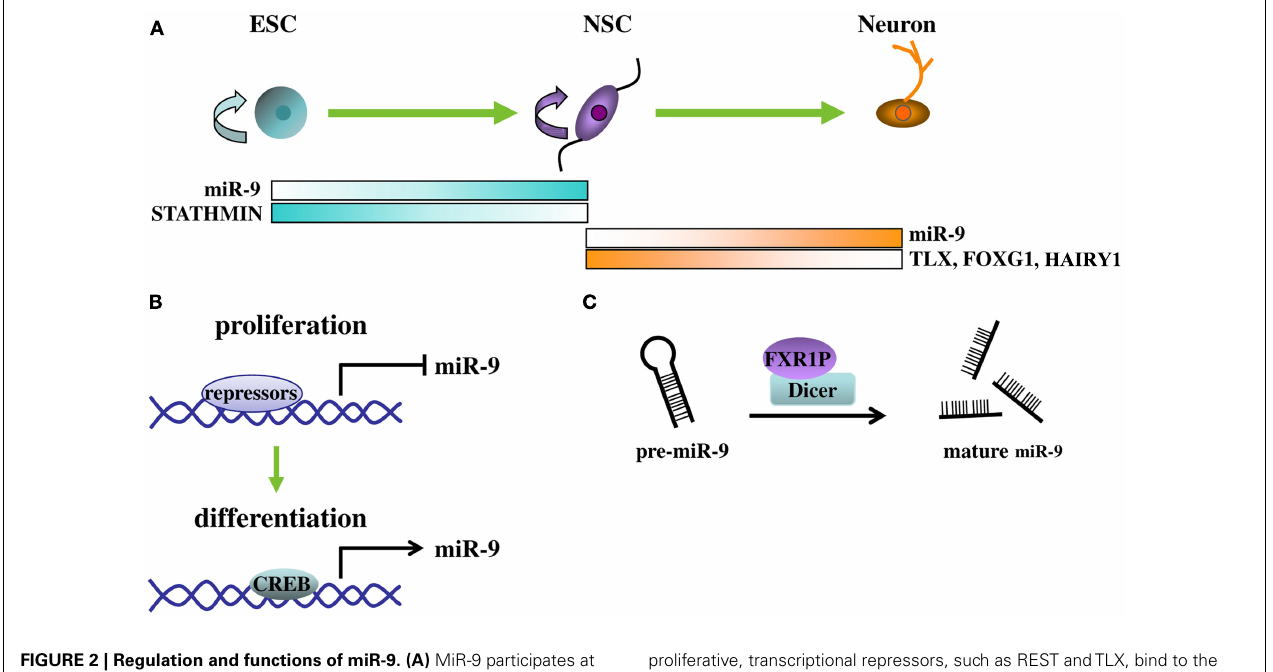
FIGURE 2 | Regulation and functions of miR-9. (A) MiR-9 participates at different stages of neurogenesis from embryonic stem cells (ESC) to NSC and to neurons. At each stage, depending on the cellular context, different target genes are regulated by miR-9 and their expression levels are inversely correlated to that of miR-9. (B) Expression of mR-9 is controlled by transcriptional repressors and activators at the transcription level. During